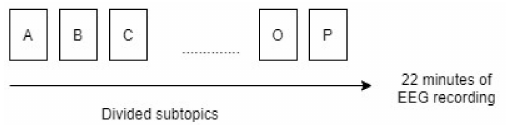
Figure 2. Subtopics in the lecture’s